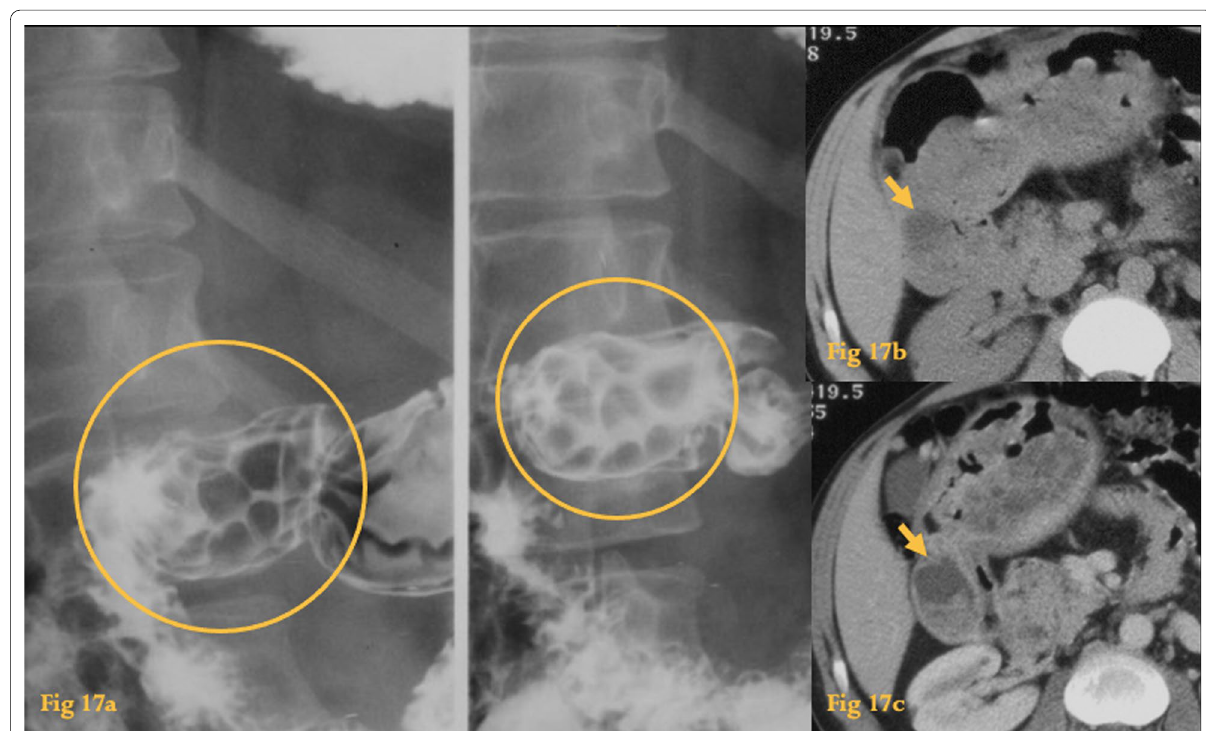
Fig. 17 Juvenile polyposis. UGIS ( a ) with multiple filling defects at the duodenal bulb (circles). Unenhanced CT of another patient ( b ) shows a fluid density endoluminal lesion at the duodenal bulb (arrow). Enhanced CT of the same patient ( c ) shows several polyps at the duodenum and stomach. The biggest is located in the duodenal bulb and presents central fluid density with very little enhancement